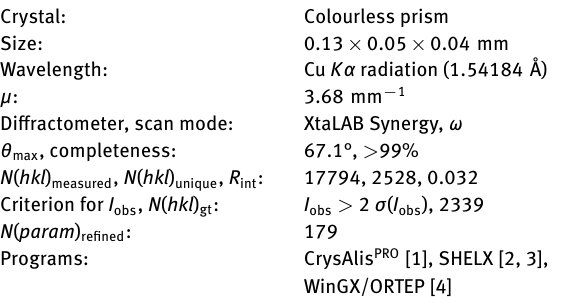
Source of material